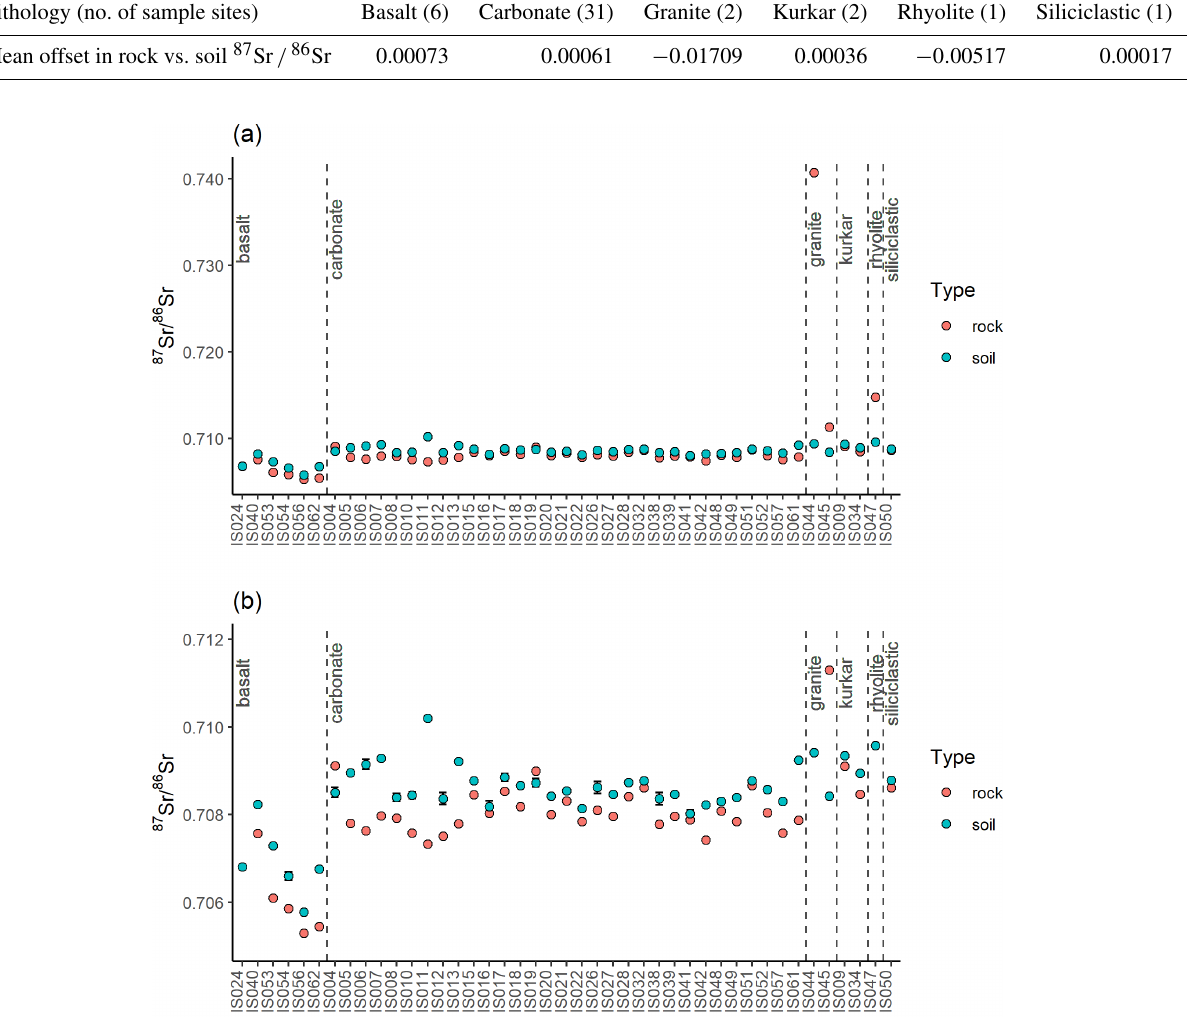
Table 2. Mean offset by lithology from rock to soil 87 Sr / 86 Sr ratios collected from the same sample locations. Lithology (no. of sample sites)